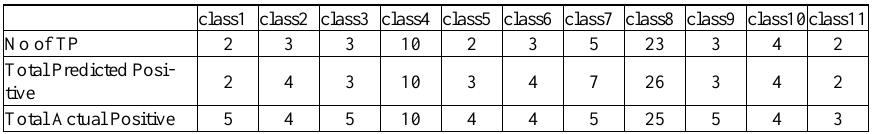
Table 6. Calculation of Precision and Recall for Linear